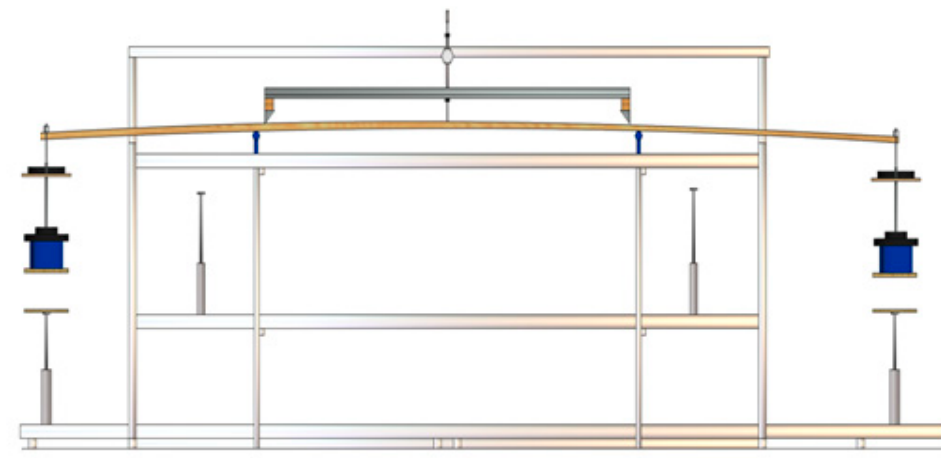
Figure 2. Lumber test stand (Grzegorz Zmy ś lony).